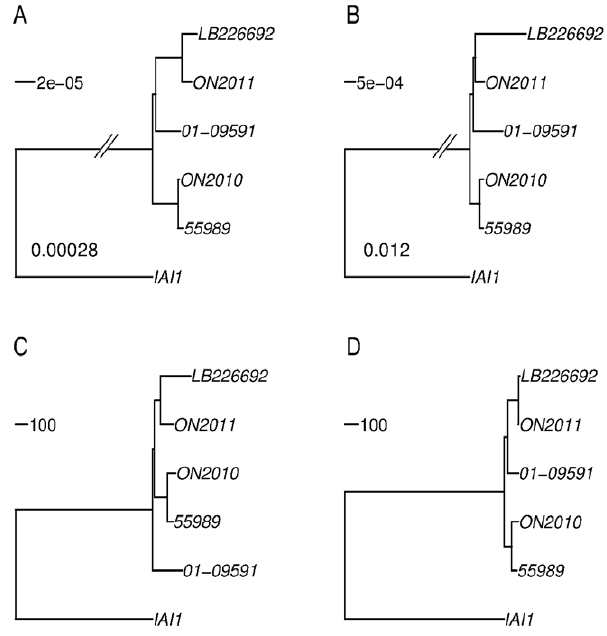
Figure 8. E. coli O104:H4 phylogenies constructed after the removal of the 125 gene involved in recombination in ON2010. A), maximum likelihood tree of the concatenated sequences of 3669 genes (3487410 characters). All branches are 100% bootstrap support- ed. B), feature frequency profiles (FFPs) tree. C), neighbor-joining tree based on the number of alleles that differ between any two strains. D), neighbor-joining tree based on the number of alleles that have none- zero DNA distance between any two strains. Unlike in C, small indels, including homopolymer sequencing errors, were not considered in D.